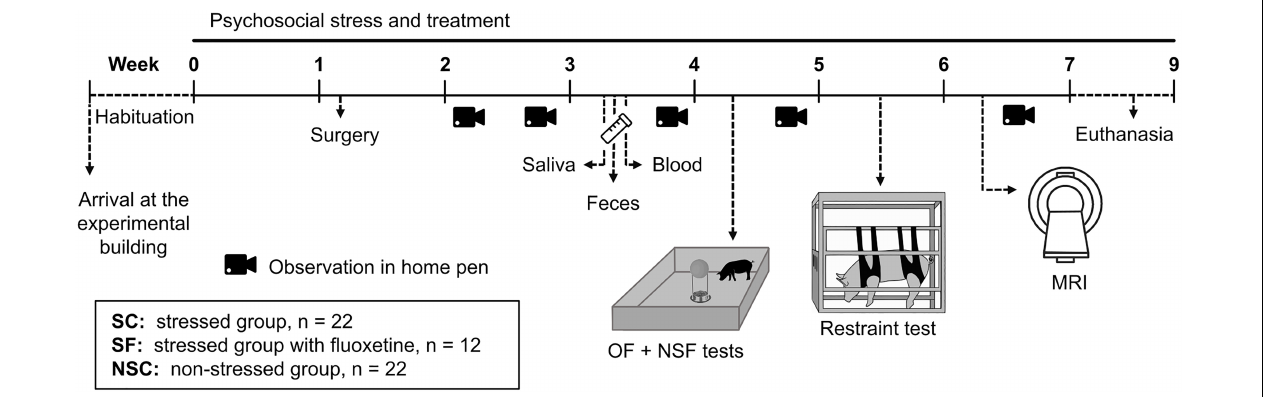
FIGURE 1 | Experimental design of the psychosocial stress, treatment, and behavioral and physiological explorations. At their arrival, pigs were separated into two rooms according to their future group and had 1 week to habituate. They were then subjected to a multifactorial psychosocial stress consisting in social isolation in a poor and unpredictable environment, without (stressed, SC) or with a treatment with the antidepressant fluoxetine (stressed fluoxetine, SF). NSC animals were kept unstressed with pair-housing in an enriched and predictable environment. Behavioral observations were conducted in home pens (Weeks 2, 3, 5, and 6), and during the Openfield (OF), Novelty-Suppressed Feeding (NSF, Week 4), and Restraint (Week 5) tests on 12 animals per group. Pigs were implanted with sensors (Week 1; n = 12/group) for continuous measurement of body temperature. Saliva ( n = 12/group), feces and blood ( n = 10/group) samples were collected (Week 3). Ten additional females from NSC and SC groups were submitted to a magnetic resonance imaging (MRI) session (Week 6). They were euthanized between Weeks 7 and 9 for further analysis of gut and brain ( n =